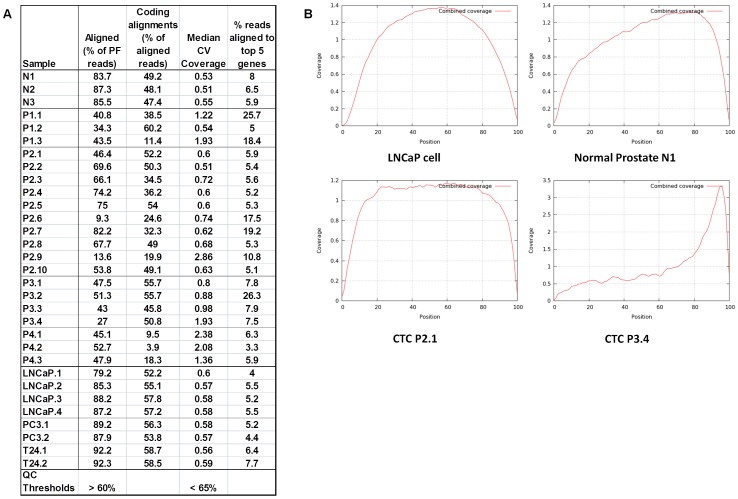
Alignment metrics of human prostate CTC mRNA-Seq sequences.(A) Percentage of passing filter (PF) reads that aligned, percentage of alignments that map to coding regions, median coverage CV, and percentage of reads that map to the five genes with the highest number of mapped reads. To calculate the “Median CV”, first the CV of coverage was calculated across each of 600 genes in a hand-picked set of quality control genes expressed in universal human RNA (Agilent), and then the median of these CVs is taken (considering only the genes with at least 1× coverage). The “% aligned” is the percentage of PF reads that align to the genome or to a splice site, excluding mitochondria and ribosomal RNA. Based on historical data, expected values for median CV and % aligned are <65% and >60%, respectively. Coding alignments are the % of reads that map to exons. The % of reads aligned to the top 5 genes for each sample are shown (B) Examples of the average length-normalized coverage across the 600 quality control genes, from samples LNCaP.3, N.1, P2.1, P3.4. Position 0 is the 5′-end of the transcripts and 100 is the extreme 3′-end of the transcript.